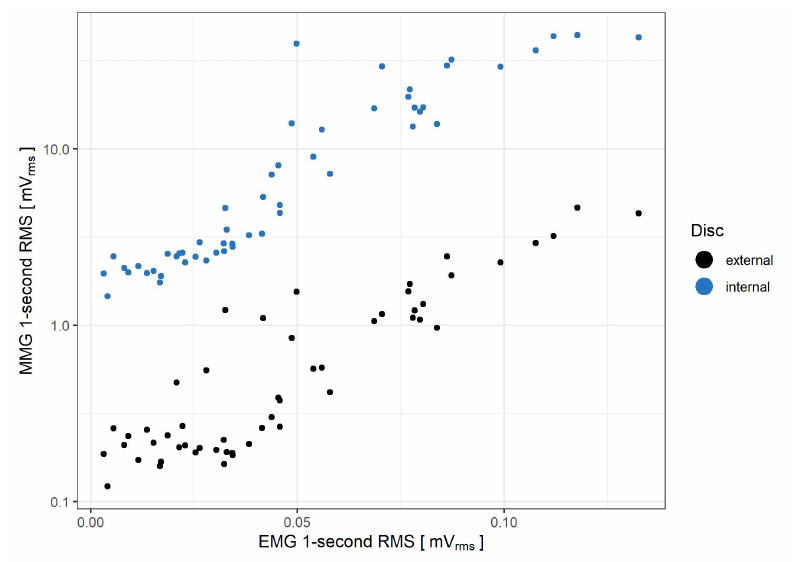
Figure 9. Comparison of MMG and EMG RMS values obtained during the ramp isometric contraction measurement. The comparison is made for both internal (blue) and external (black) piezoelectric discs.